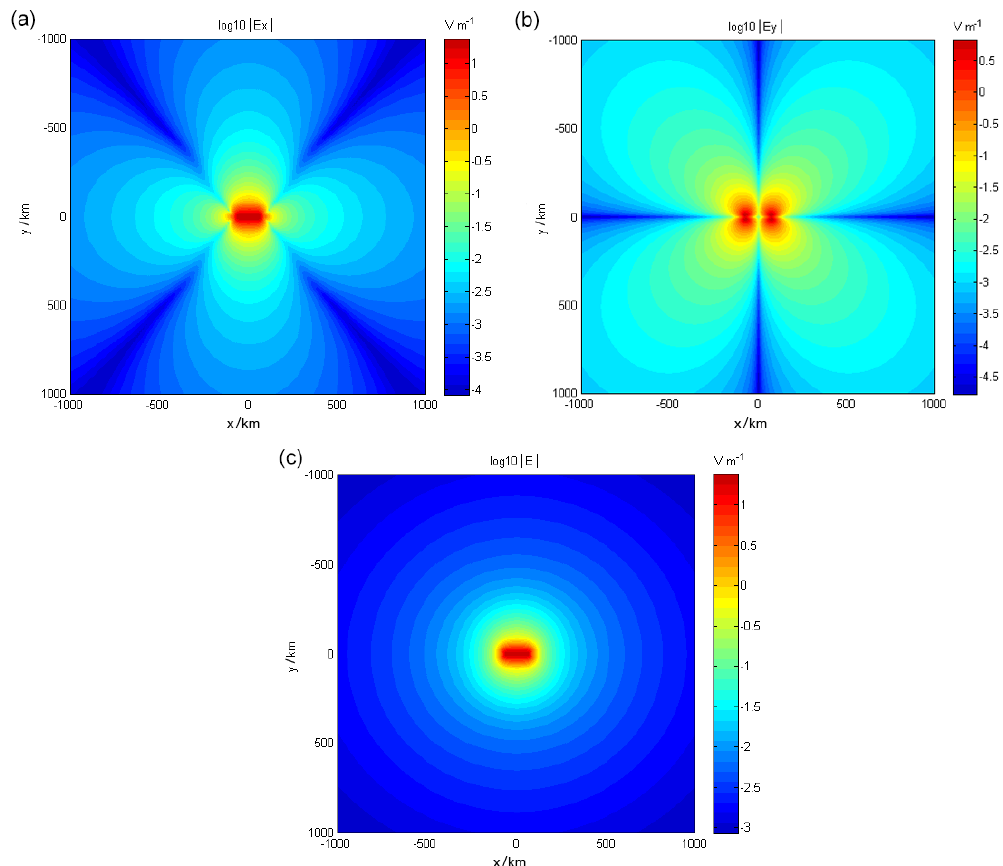
Figure 8. Two-dimensional distributions of electrical field power: (a) | E x | , (b) | E y | , and (c) total | E | after a logarithm calculation for the Wenchuan source using an Earth–air–ionosphere